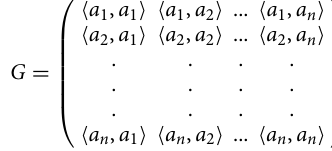
where < a i , a j > denotes the inner product of two vectors. The matrix G is a positive definite matrix. The proof of G is as follows: